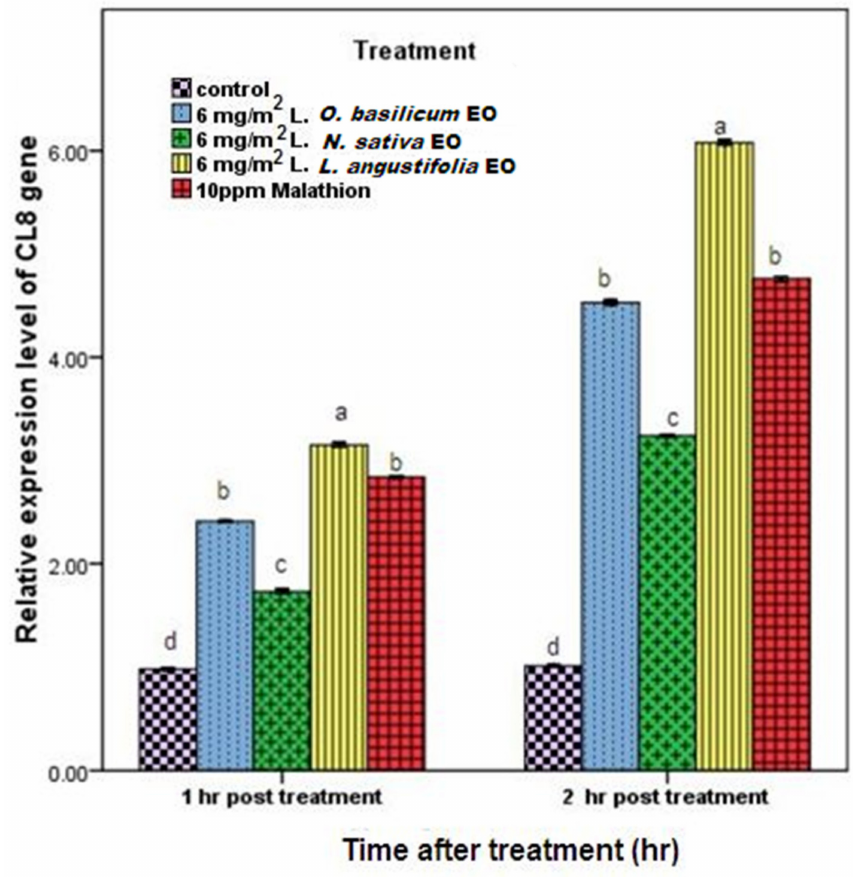
Figure 7. Relative gene expression of DEGs gene (CL8) gene in S. oryzae adults after 1 and 2 h treated with 6 mg/cm 2 of O. basilicum, N. sativa, and L. angustifolia EOs (mean ± SD) compared with standard chemical insecticide (10 ppm malathion). Different letters indicate significant differences between different treatments at p <